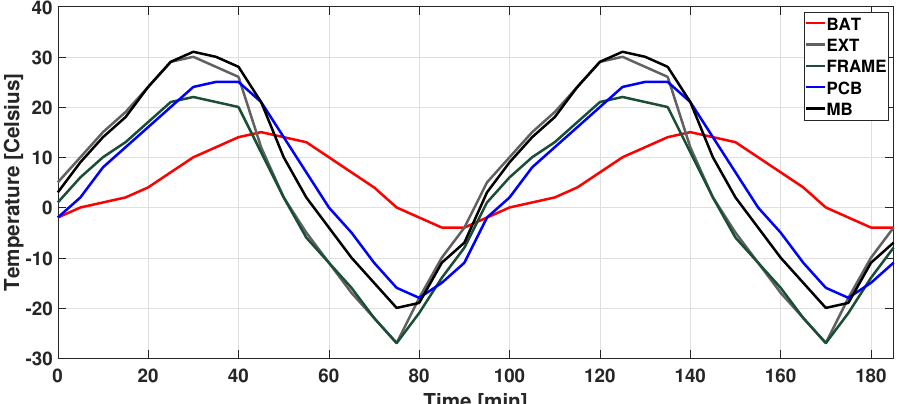
Figure 1. Temperature measurements in SwissCube [10] (BAT: battery, EXT: external, PCB: printed circuit board, and MB: